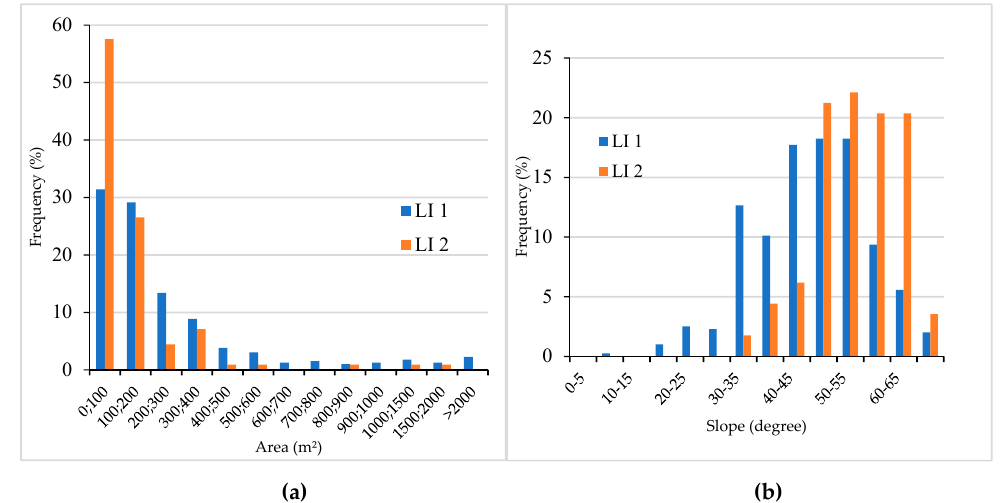
Figure 4. Distribution of the area (a) and slope (b) per landslides LI 1 and LI 2.